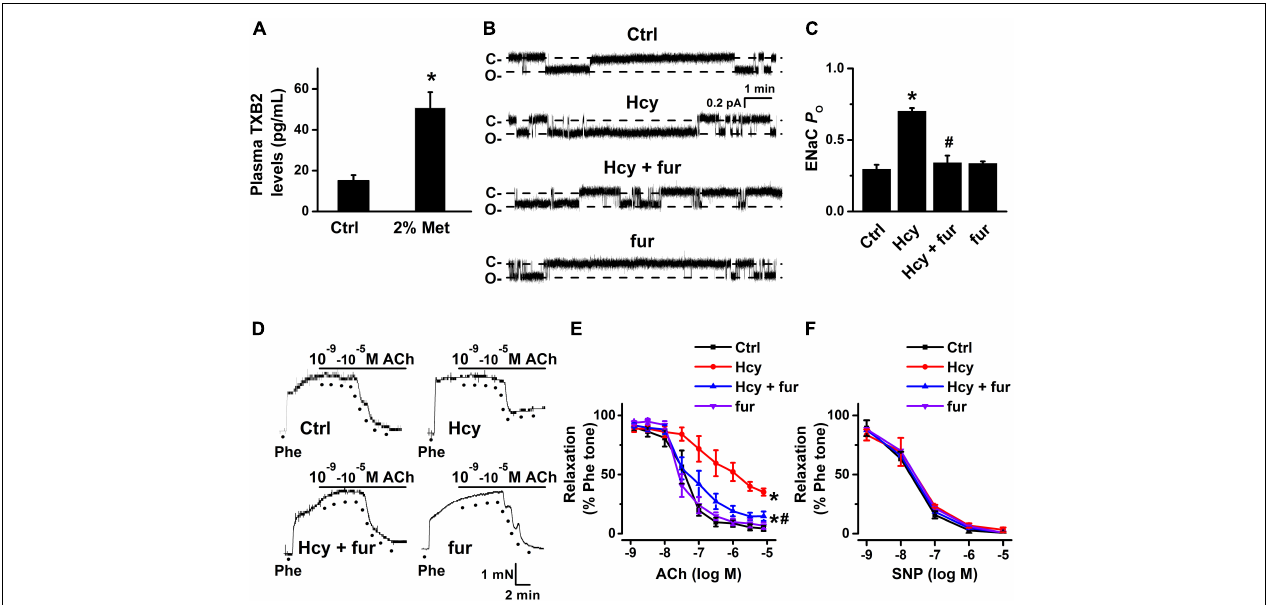
FIGURE 6 | Inhibition of TXB2 by furegrelate ameliorated Hcy-induced increase in ENaC activity and impairment of EDR in mouse aorta. (A) Mean plasma TXB2 levels, the stable metabolic product of TXA 2 , were measured in control and L-methionine (Met)-treated mice. Data are means ± SEM of six mice. * P < 0.05 vs. ctrl. (B) Representative ENaC single-channel currents recorded in endothelial cells from split-open aorta either under control condition or, respectively, treated with 100 µ M Hcy, 100 µ M Hcy plus 10 µ M furegrelate (fur), or 10 µ M furegrelate alone for 6 h. (C) Summarized ENaC P O under conditions as shown in (B) . Data are means ± SEM of six mice. * P < 0.05 vs. ctrl; # P < 0.05 vs. Hcy. (D) Representative traces obtained from wire myograph assays under each indicated condition and (E) summarized data of ACh-induced relaxation of aorta under each indicated condition. The first dot indicates the application of 10 − 9 M ACh to the 1 µ M Phe precontracted arterial rings, whereas the following dots indicate ACh concentrations increasing from 10 − 8 . 5 to 10 − 5 M. Data are means ± SEM of six mice. * P < 0.05 vs. ctrl; # P < 0.05 vs. Hcy. (F) Summary of artery relaxation induced by 10 − 9 to 10 − 5 M SNP in aortas from the four individual experiments under indicated